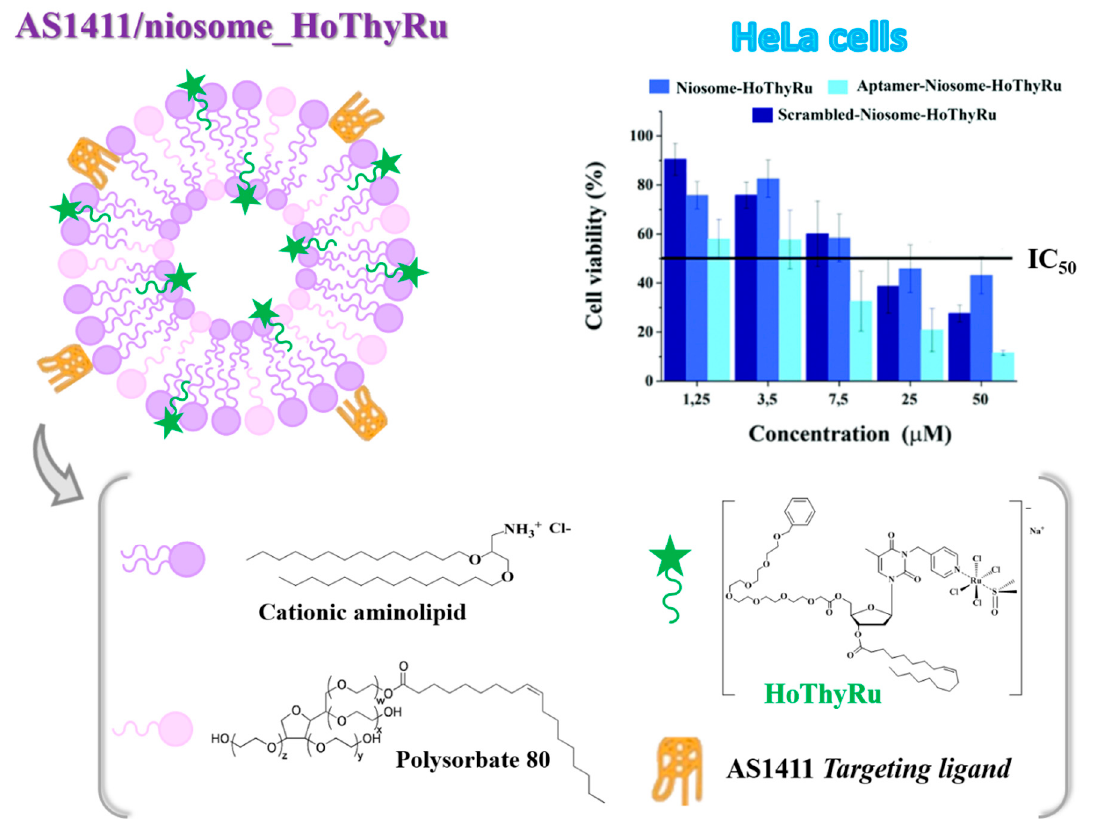
Figure 17. Schematic representation of niosome formulations based on a cationic aminolipid and the polysorbate 80, also containing the nucleolipid-based Ru(III) complex HoThyRu along with AS1411. On the right, the concentration/effects bar graphs obtained after in vitro treatment on HeLa cancer cells were also reported as representative examples. Figures were adapted from [109].